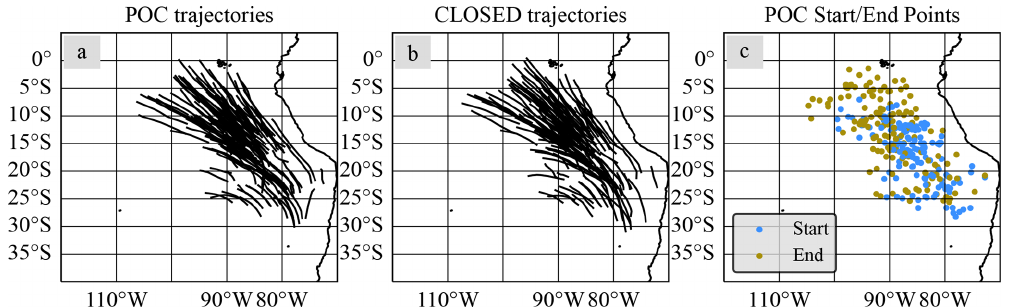
Figure 5. Modern-Era Retrospective analysis for Research and Applications, version 2, trajectories that traverse closed-cell stratocumulus and develop into pockets of open cells are shown in panel (a) , the MERRA trajectories that traverse through closed-cell stratocumulus and never develop into pockets of open cells are shown in panel (b) , and POC starting and ending points are shown in panel (c)